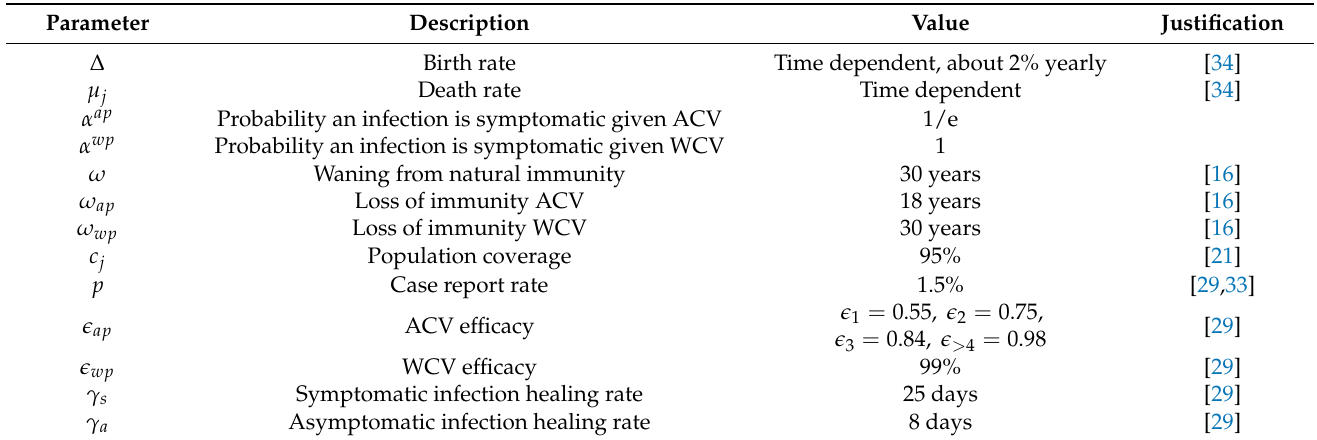
Table 1. Fixed parameters.